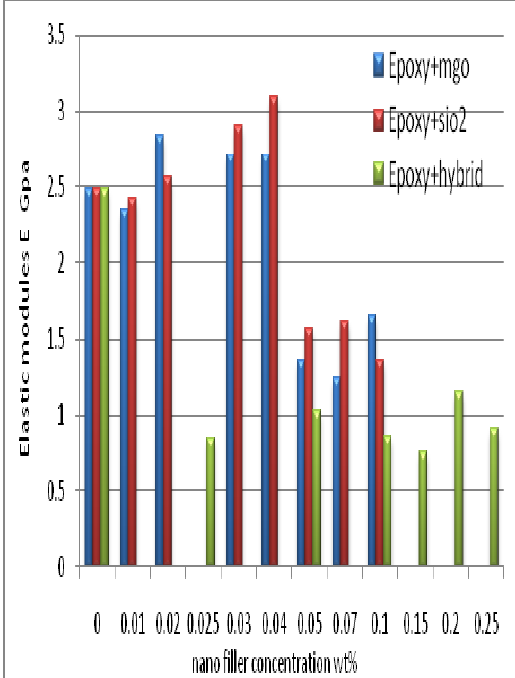
Fig. 4: The behavior of weight loss with nano filler